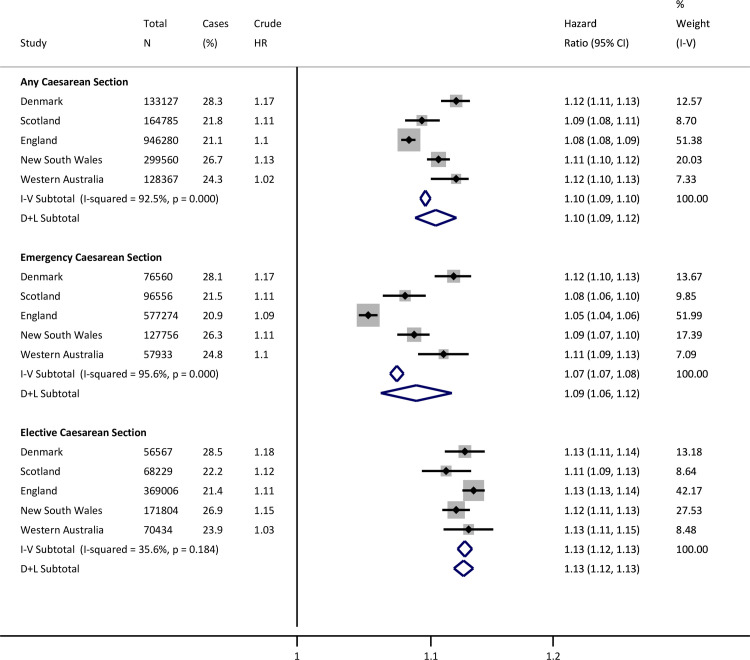
Site-specific and meta-analysis HRs for infection-related hospitalisations.Estimates are from recurrent events models fitted for total time. Models adjusted for sex, gestational age, birth weight z-score, smoking during pregnancy, maternal age at birth, parity, area level deprivation, birth year, medical indication for type of delivery, and season of birth. Reference is vaginal births. CI, confidence interval; D+L, DerSimonian and Laird random effects model; HR, hazard ratio; I-V, inverse-variance weighted fixed effects model.